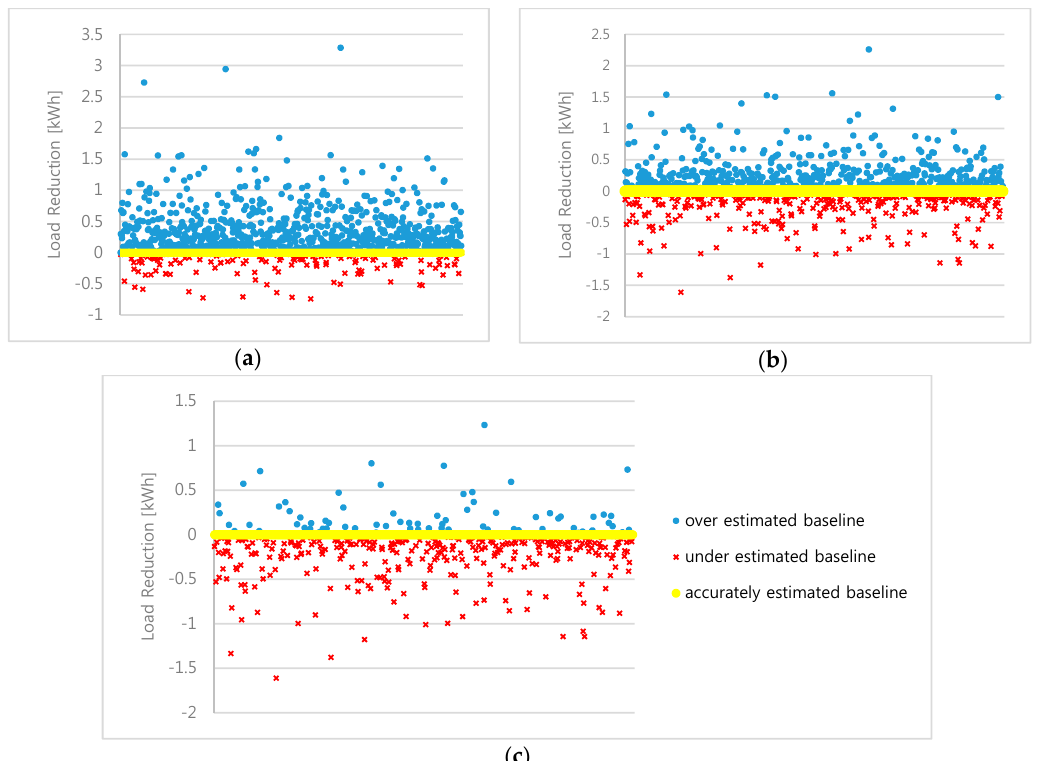
Figure 9. Free rider distributions for ( a ) high 4 of 5, ( b ) regression, and ( c ) proposed two-step methodology using both regression and the new payment rule.